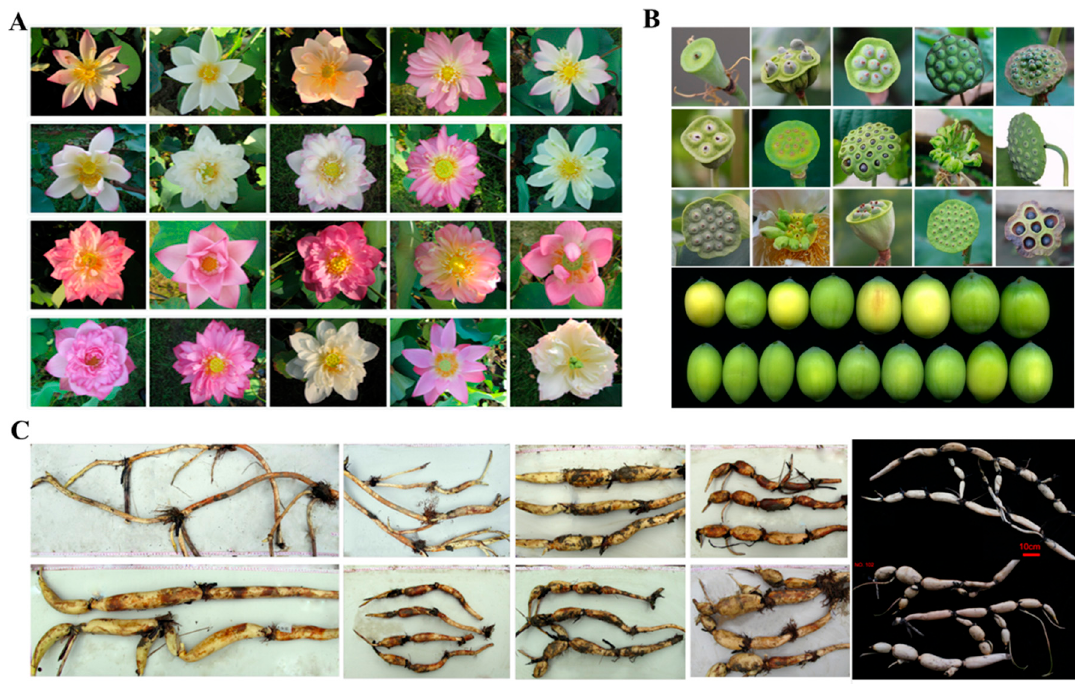
Figure 2. The diversified phenotypes of the Asian lotus germplasm. ( A ) Flower lotus germplasm showing di ff erent flower color and shape. ( B ) Seed lotus germplasm showing di ff erent size and shape of seed and seedpod. ( C ) Rhizome lotus germplasm showing di ff erent branching, elongation and expansion of the rhizome.